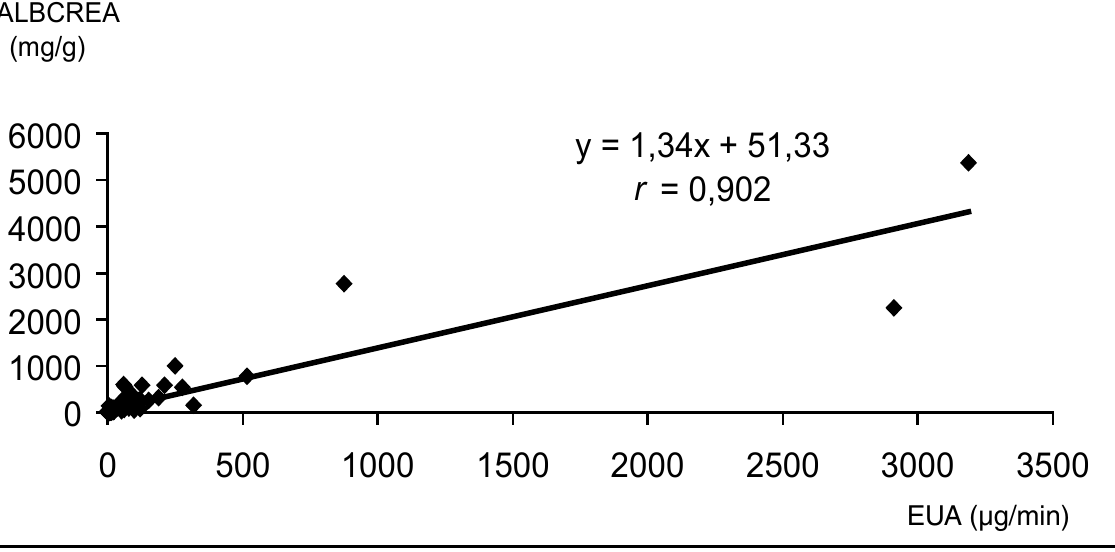
Figura – Relação entre excreção urinária de albumina e relação